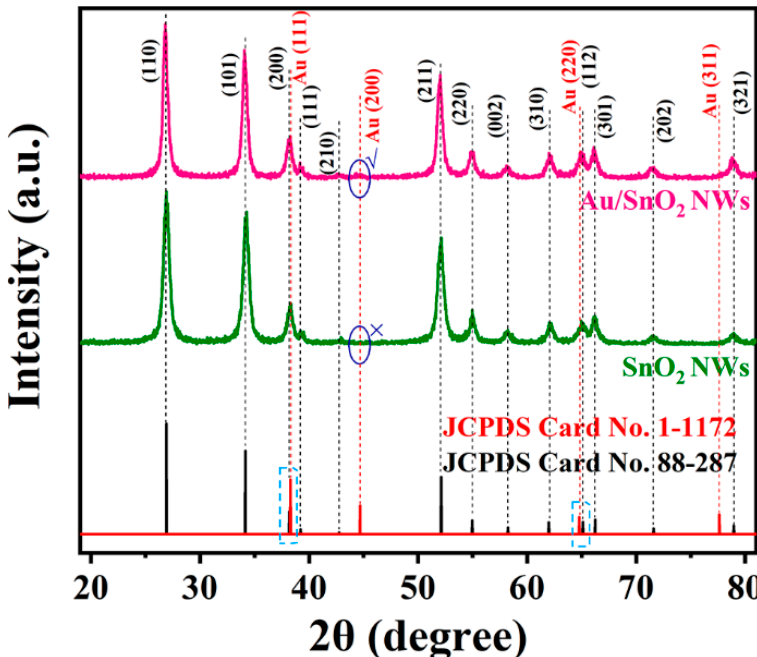
Figure 1. XRD patterns of as-synthesized SnO 2 and Au/SnO 2 NWs.